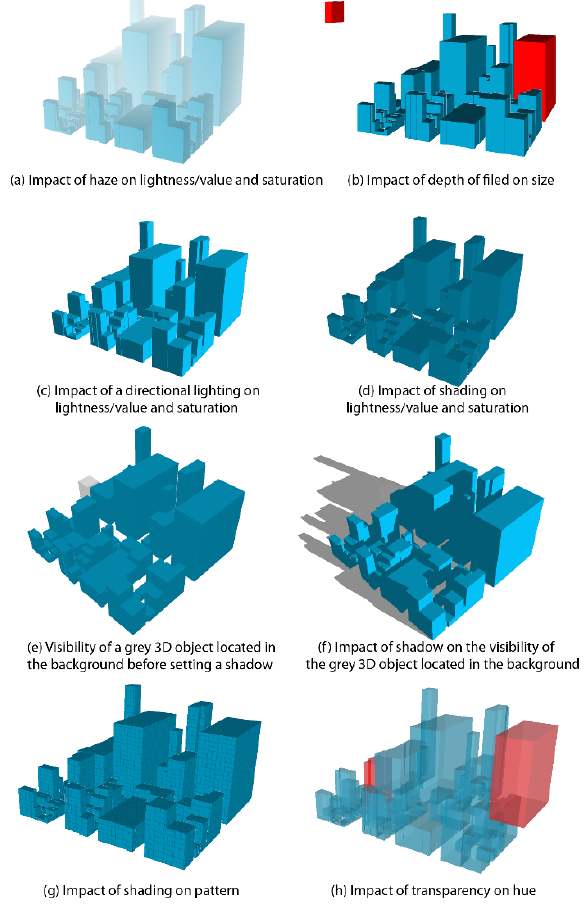
Figure 4 Visual impacts of 3D environment parameters and static retinal